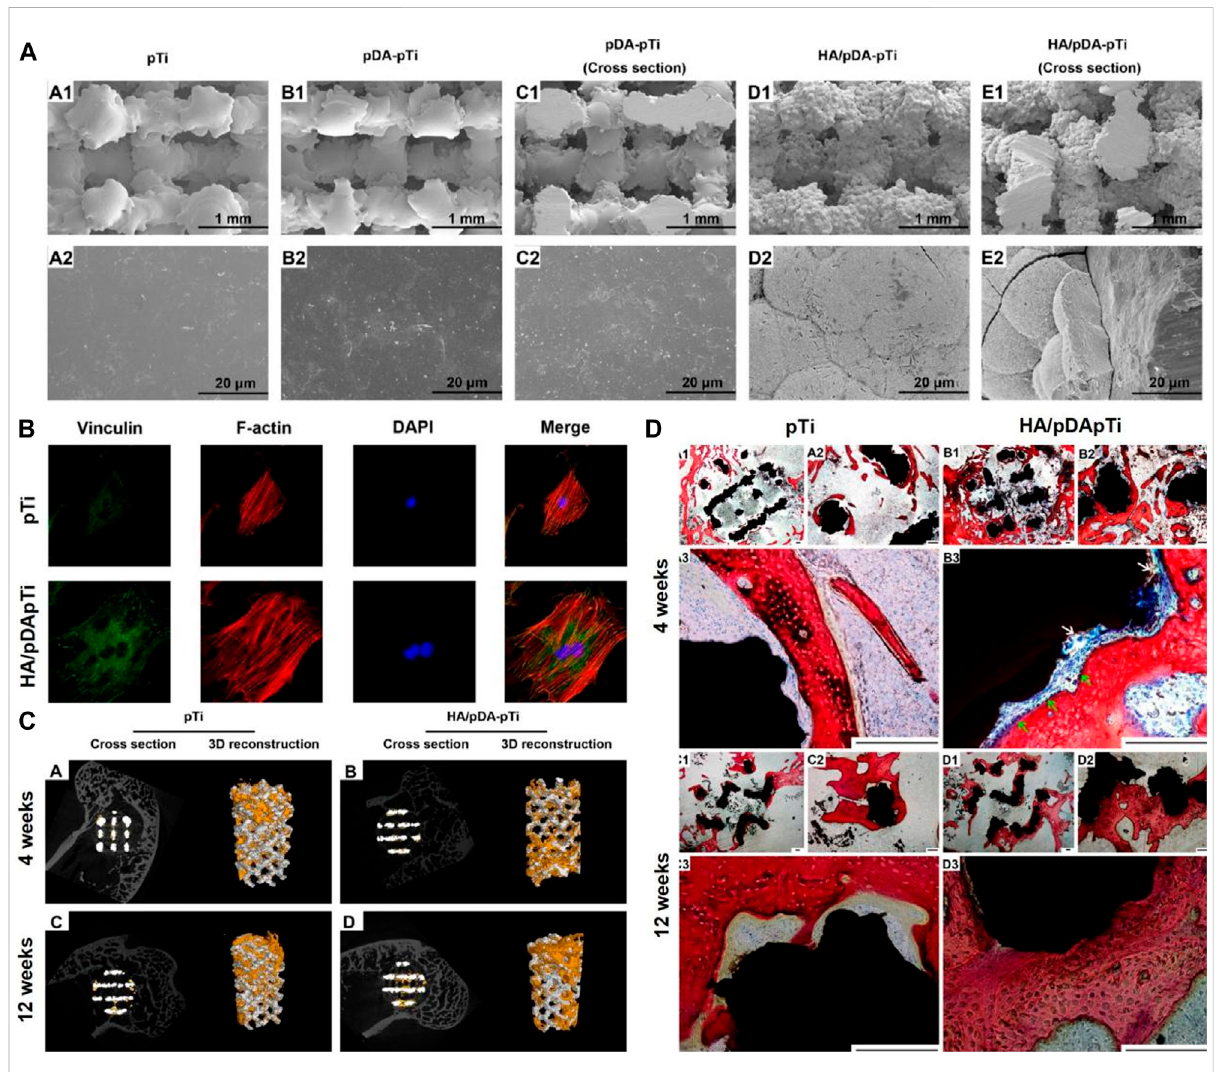
Three-Dimensional Porous Ti6Al4V Scaffolds coated by Polydopamine improve Osteointegration and Osteogenesis (Li et al., 2015). (A) SEM images of pTi, PDA-pTi, PDA-pTi (cross section), HA/PDA-pTi, and HA/PDA-pTi (cross section). (B) Fluorescent staining photos of MC3T3-E1 cells cultured onpTiandHA/PDA-pTi. (C) Micro-CTimagesofthepTiandHA/PDA-pTiimplants at4and12 weeks. (D) Van-Gieson stainingimages ofpTi and HA/PDA-pTi implants at 4 and 12 weeks. (Reproduced from the references with